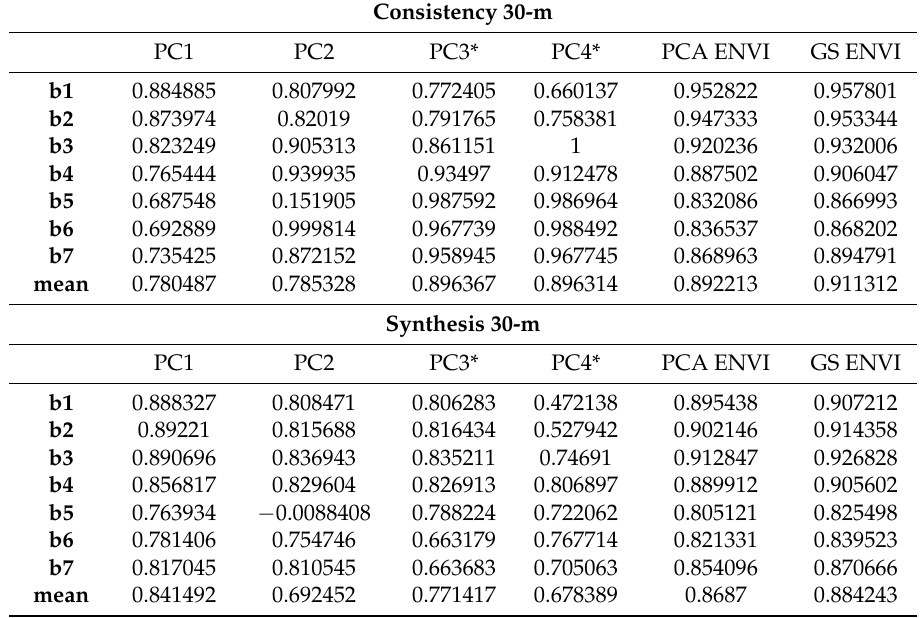
Table 7. Interband UIQI for Landsat 8 dataset. Values of the UIQI range from +1 to − 1, while 1 is considered as the best value. PC3* and PC4* were used to compare the result and explain it in a wider